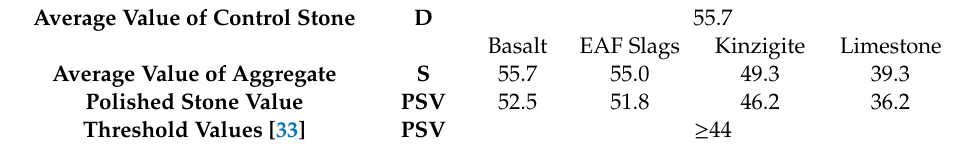
Table 4. Polished stone value results for the examined aggregates.